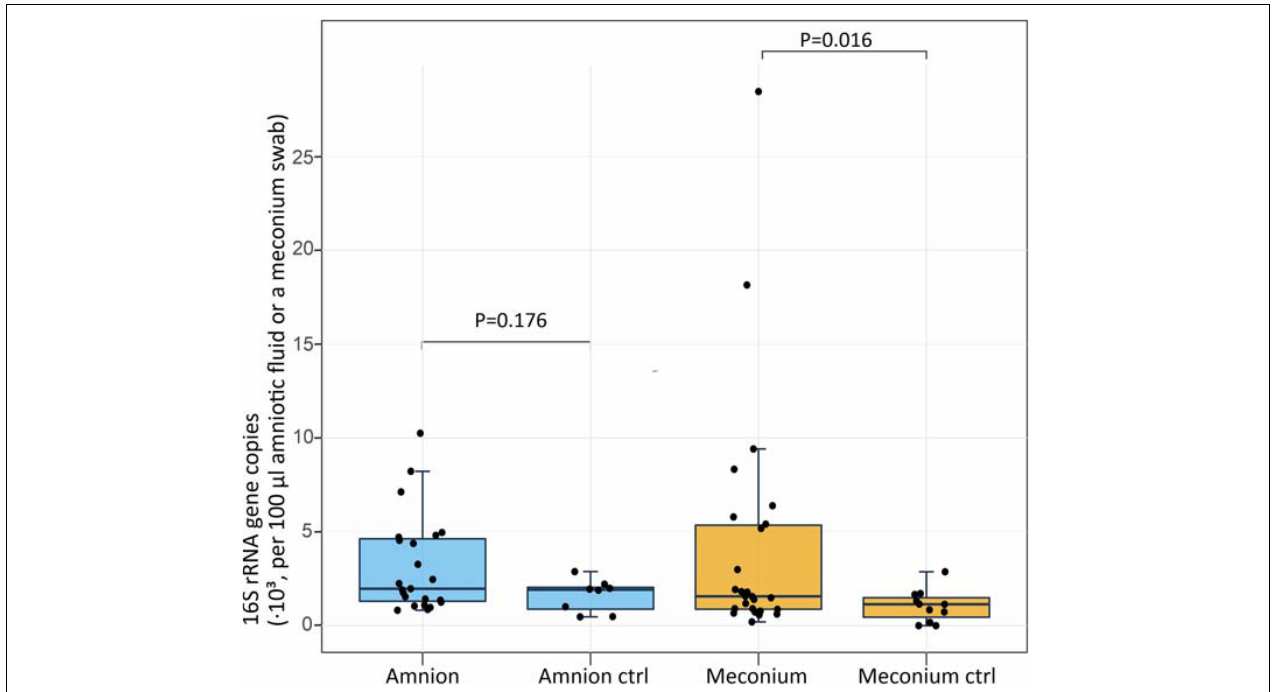
FIGURE 1 | Absolute 16S rRNA gene copy numbers per 100 µ l of centrifuged amniotic fluid ( n = 23, negative controls n = 8) and per meconium sampling swab ( n = 25, negative controls n = 11). The midline of the box is the median, with the upper and lower limits of the box being the third and first quartile. The whiskers extend up to 1.5 times the interquartile range from the box to the furthest data point within that distance.